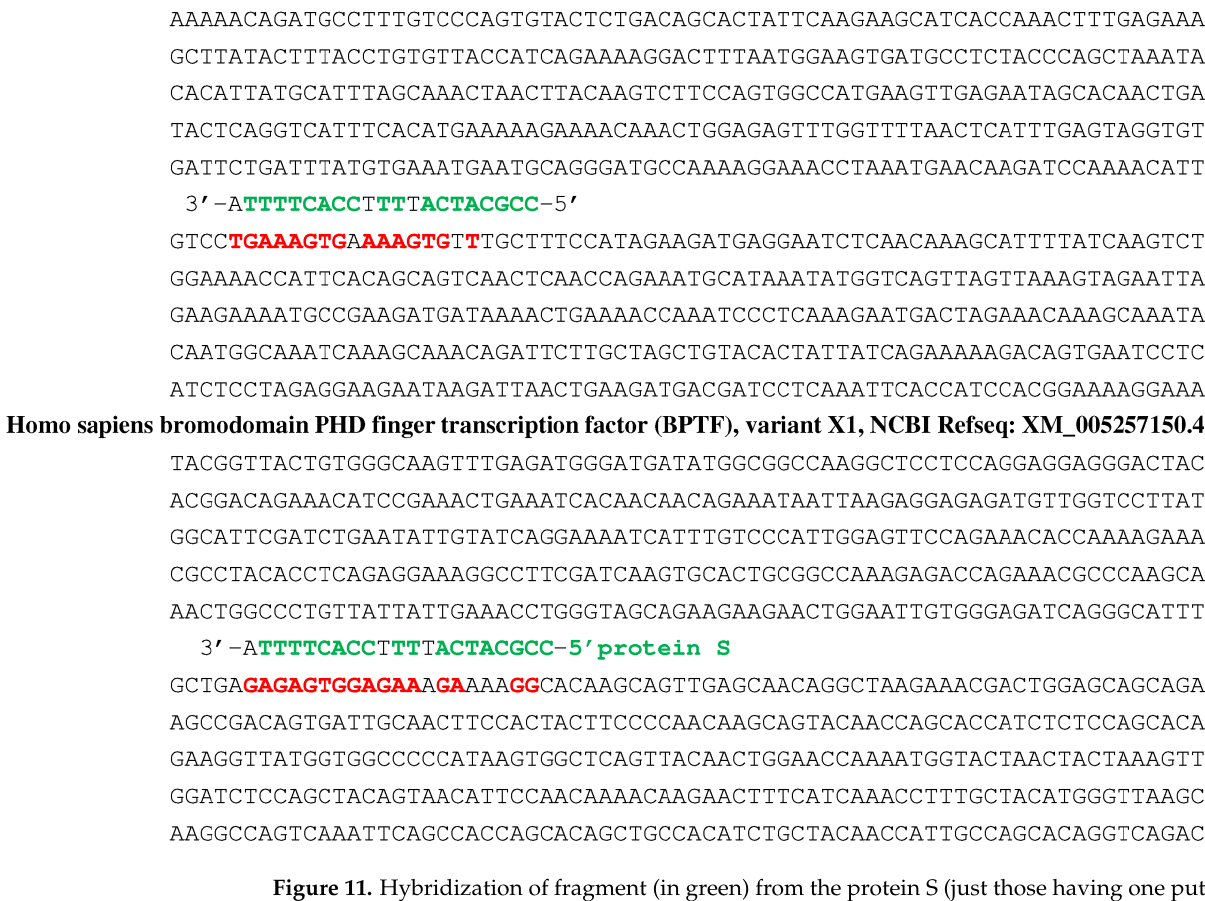
Figure 11. Hybridization of fragment (in green) from the protein S (just those having one putative miRNA-like inhibitory effect on beta-globin in Figure 7) on two circular RNA, hsa_circ_0107544 and hsa_circ_0001195, coming from human ankyrin- (top) and bromo-domains (bottom) [150]. Red color corresponds to the human gene sequences anti-matching a protein S sequence.